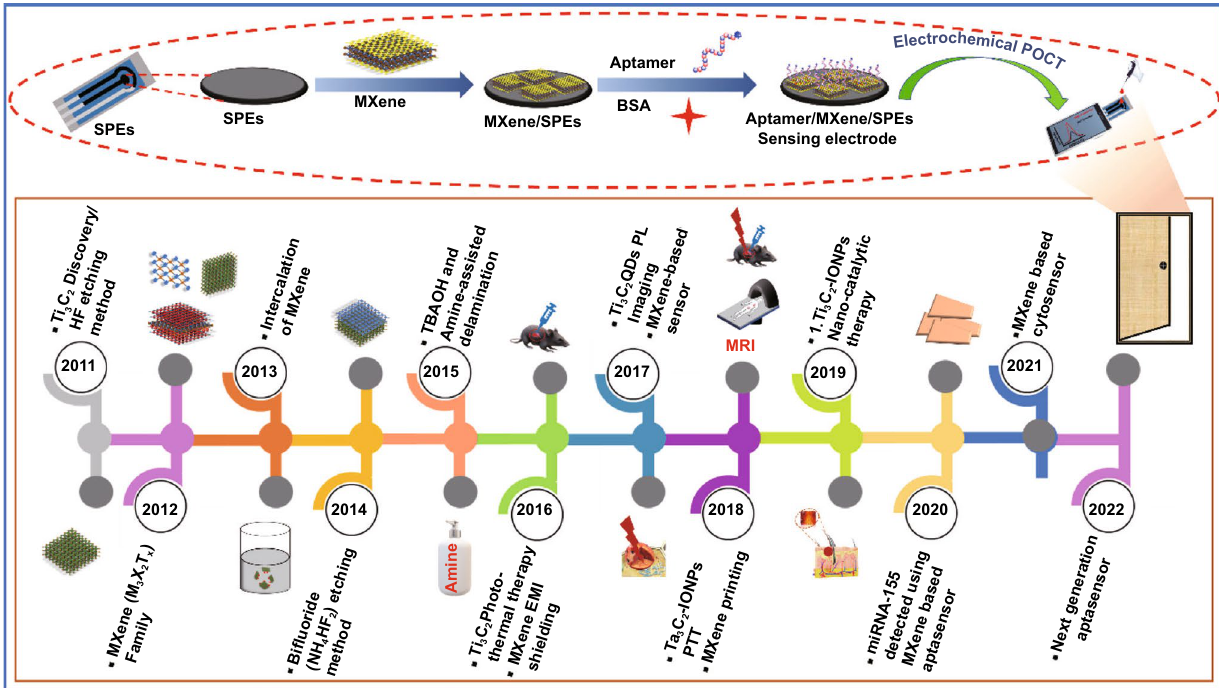
Fig. 2 Timeline of MXene for the synthesis and its application in the biomedical